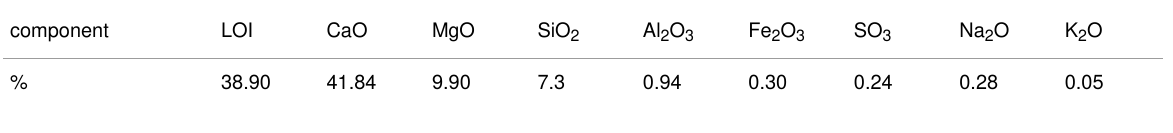
Table 1: Chemical composition of the NDL catalyst. LOI: loss of ignition. component